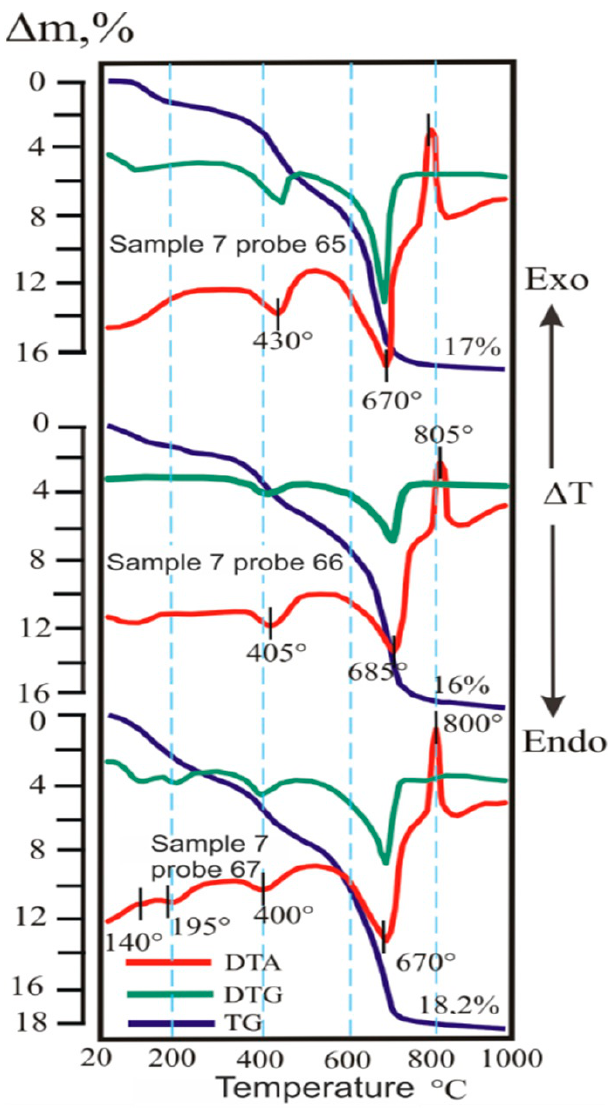
Figure 6. Derivatograms of serpentines of the Donskoye deposit. Exo—exothermic effect, Endo— endothermic effect, ∆ T—change in the enthalpy of the system during the thermal transformation of the tested samples.